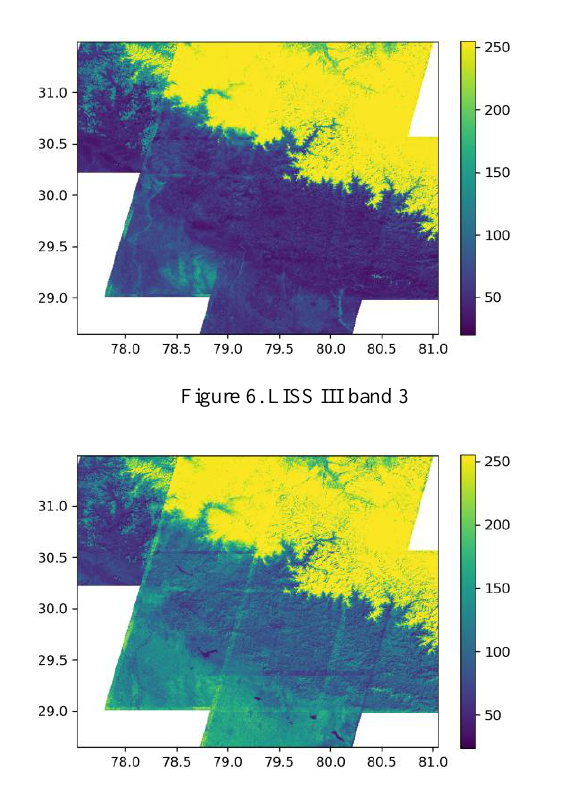
Figure 6. LISS III band 3